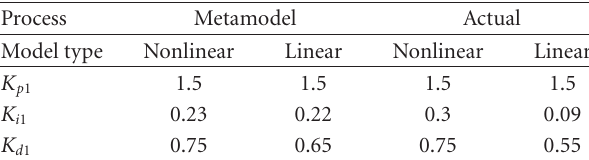
Table 3: Best gains for the cruise control system.